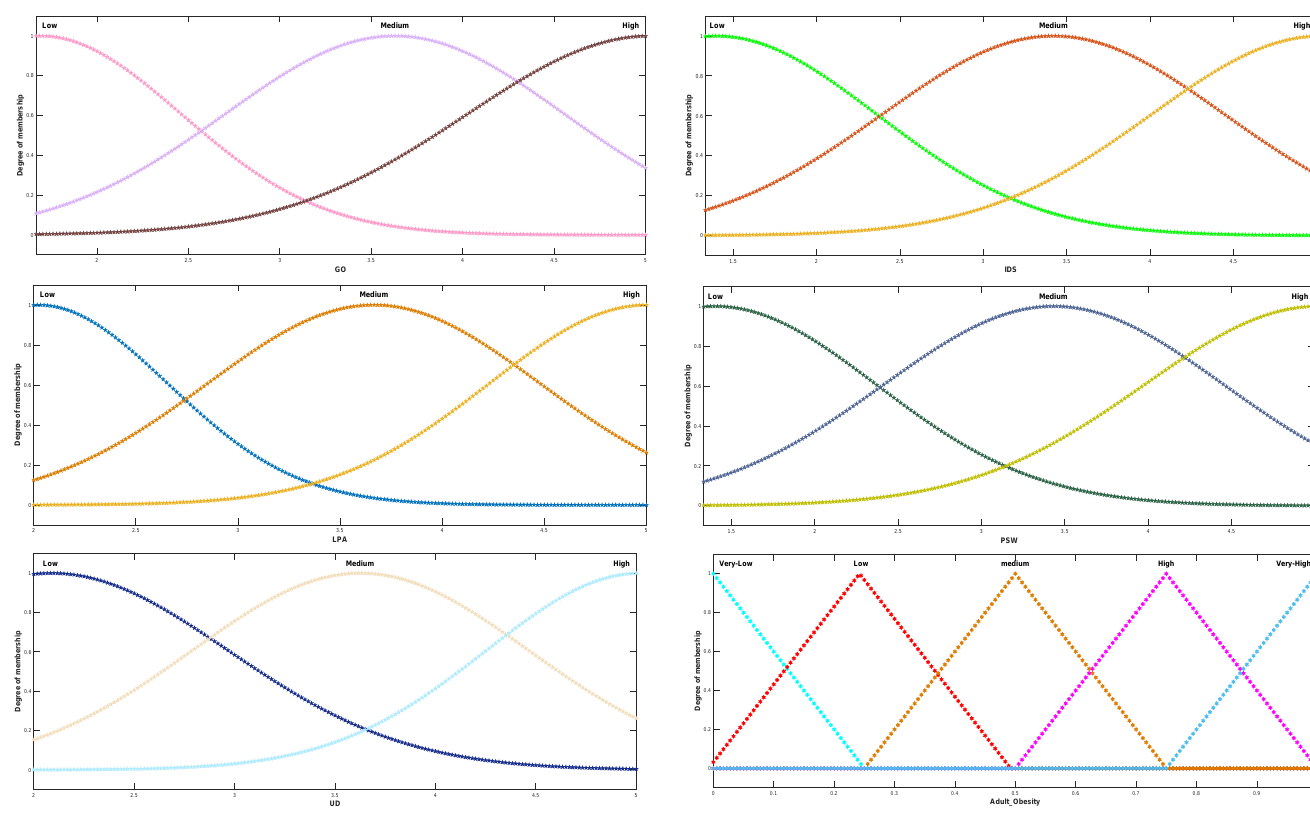
Figure 7. Membership functions of fuzzy-logic.